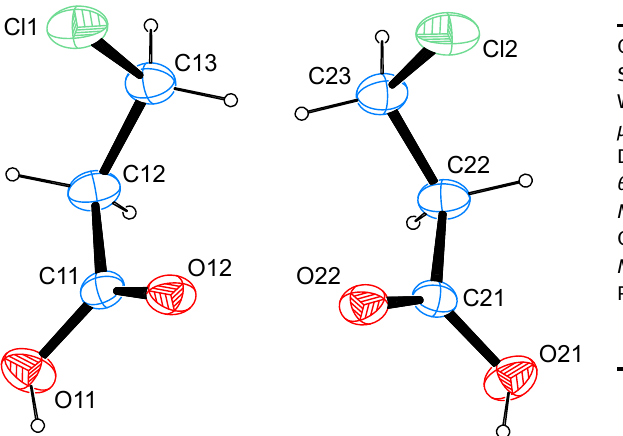
Table  : Data collection and